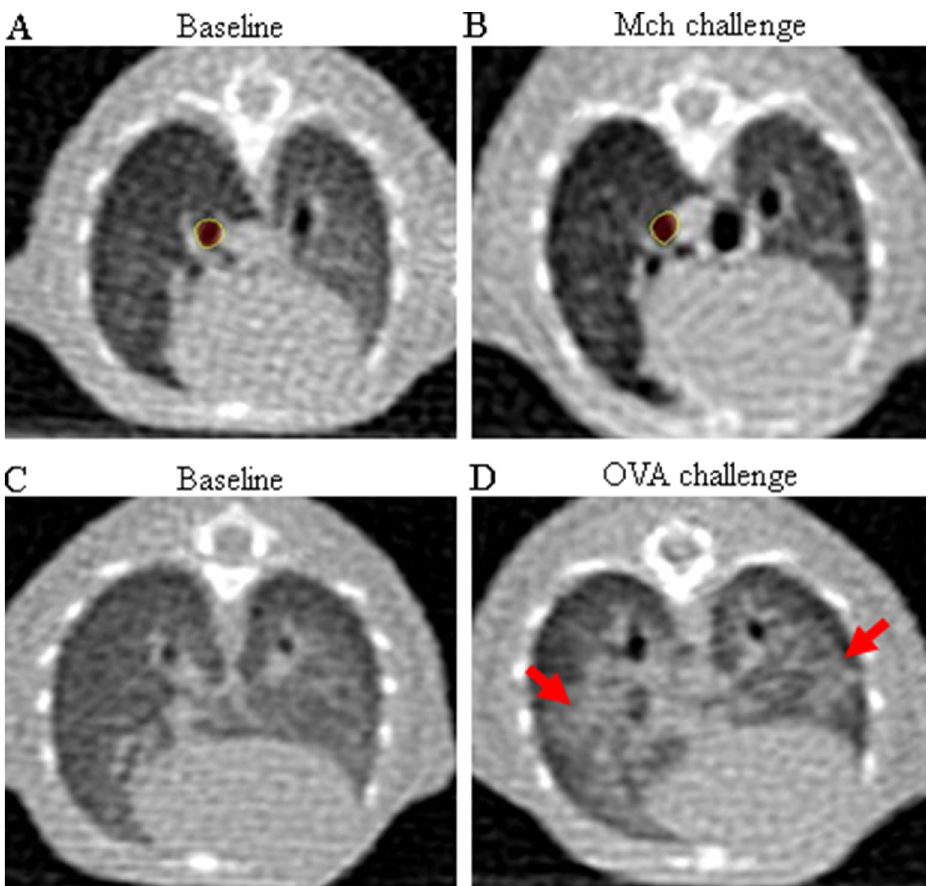
Figure 3. Parenchymal changes during early phase reaction in asthma model. (A) Baseline image before methacholine challenge. (B) Image of 5 min after methacholine challenge. (C) Baseline image before OVA challenge. (D) Image of 5 min after OVA challenge. Methacholine challenge did not induce any parenchymal changes nor bronchial changes. However, prominent peribronchial attenuation developed along with dilation of bronchus by OVA